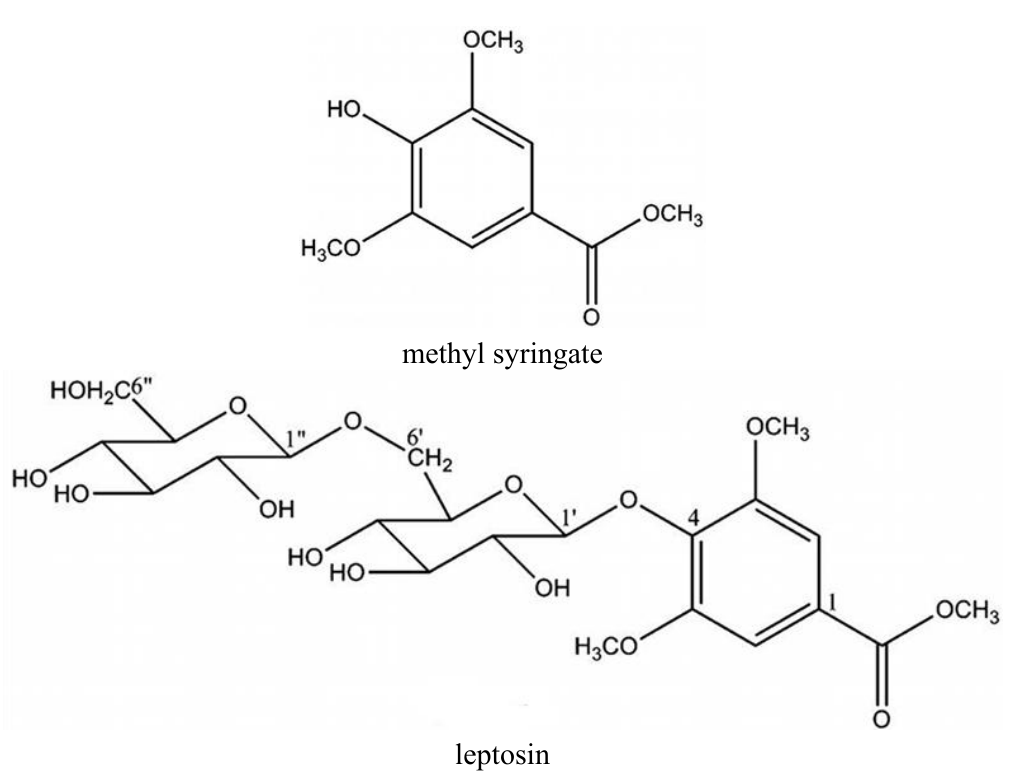
Figure 1. Chemical structures of methyl syringate and leptosin.